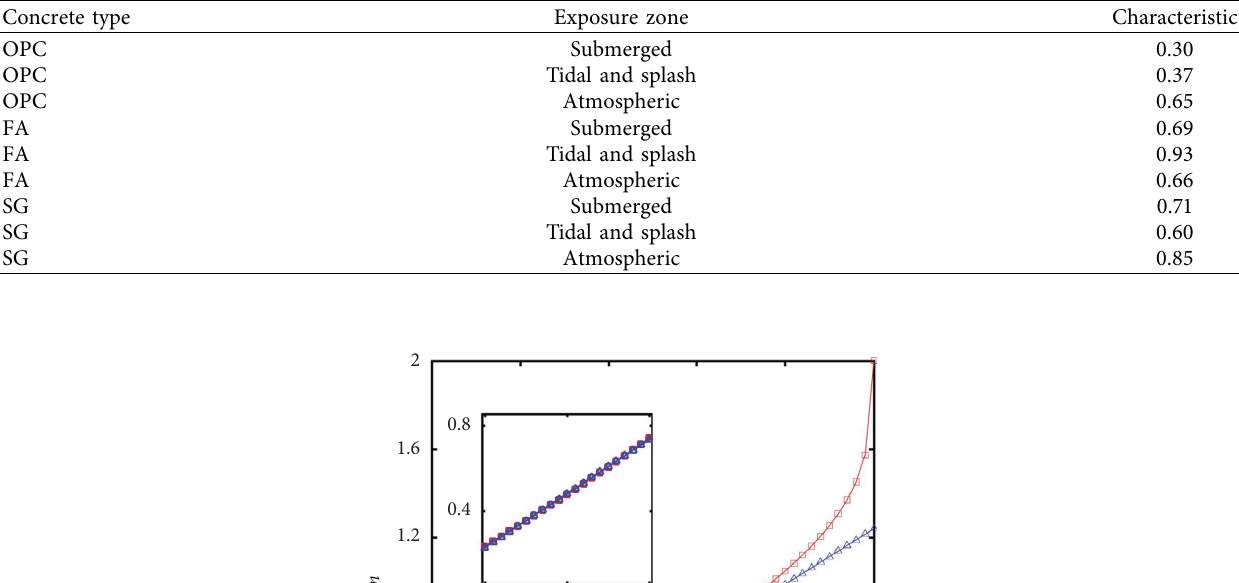
Table 1: Te characteristic values of the aging factor.